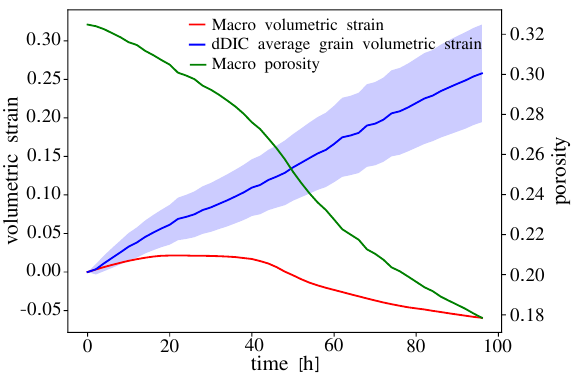
Figure 4. 3D rendering of the segmented couscous specimen. Every single grain has its own label and its kinematics can be followed thorough the process.